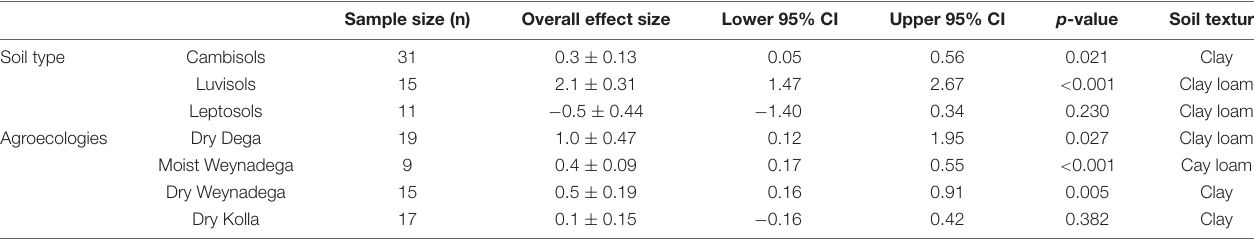
TABLE 4 | Changes in total soil nitrogen after the establishment of exclosures on communal grazing